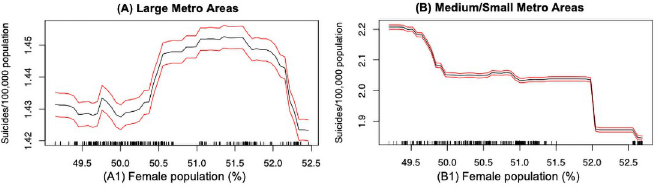
Fig 7. Suicide mortality rate and gender: (A) Large metro areas; (B) Medium/small metro areas. Rug lines on the x axis indicate prevalence of data points; black curve is the average marginal effect of the predictor variable; red lines indicate the 95% confidence